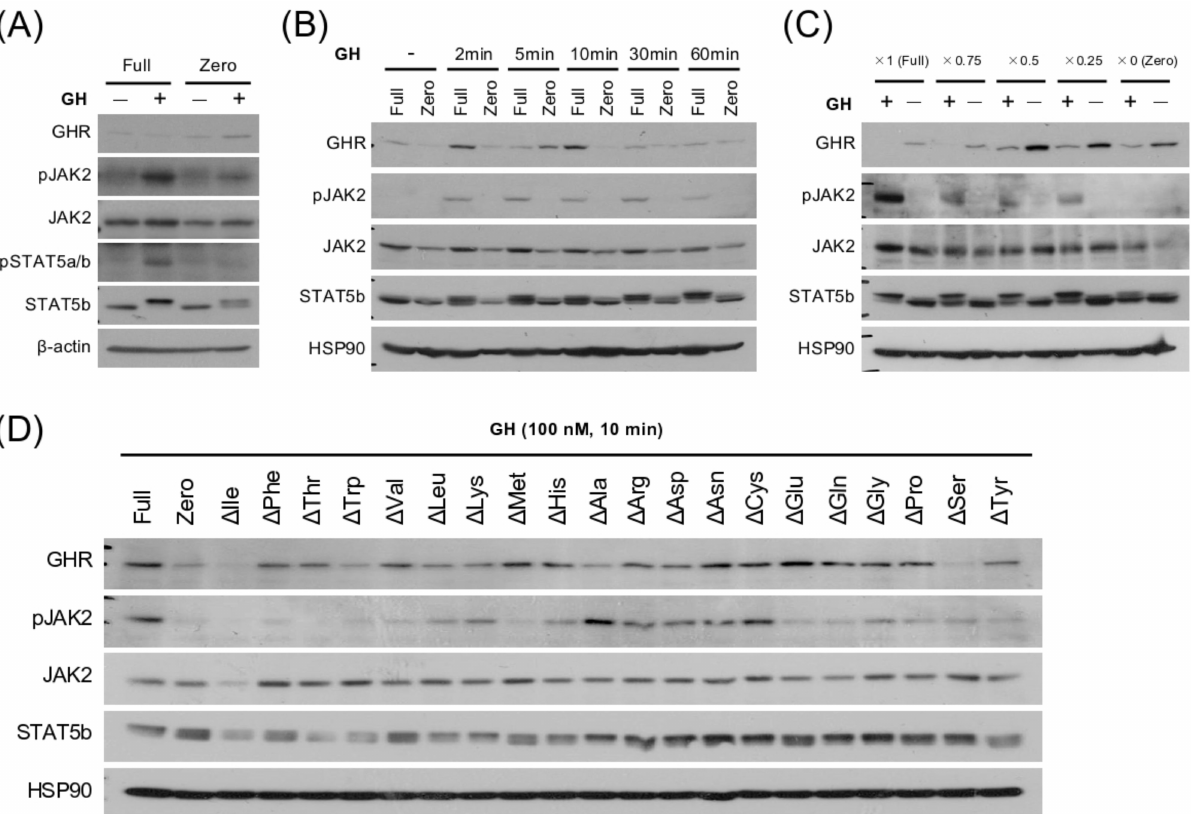
Figure 4. Essential amino acids are required for GH signal transduction; ( A ) Fao cells were cultured in Full or Zero medium for 24 h, and 100 nM GH was added. After 10 min of GH stimulation, proteins related to GH signaling were analyzed by immunoblotting; ( B ) Fao cells were cultured in Full or Zero medium for 24 h, and then 100 nM GH was added, and cells were incubated for another 2, 5, 10, 30, and 60 min. Proteins related to GH signaling were analyzed by immunoblotting.( C ) Fao cells were cultured in Full medium and media with amino acid concentrations of 0.75, 0.5, 0.25, and 0 (Zero) times. Full medium concentration for 24 h; 100 nM GH was added. After 10 min of GH stimulation, proteins related to GH signaling were analyzed by immunoblotting. ( D ) Fao cells were cultured in Full, Zero, or Full medium lacking a single amino acid ( ∆ —) for 24 h, and then 100 nM GH was added. After 10 min of GH stimulation, proteins related to GH signaling were analyzed by